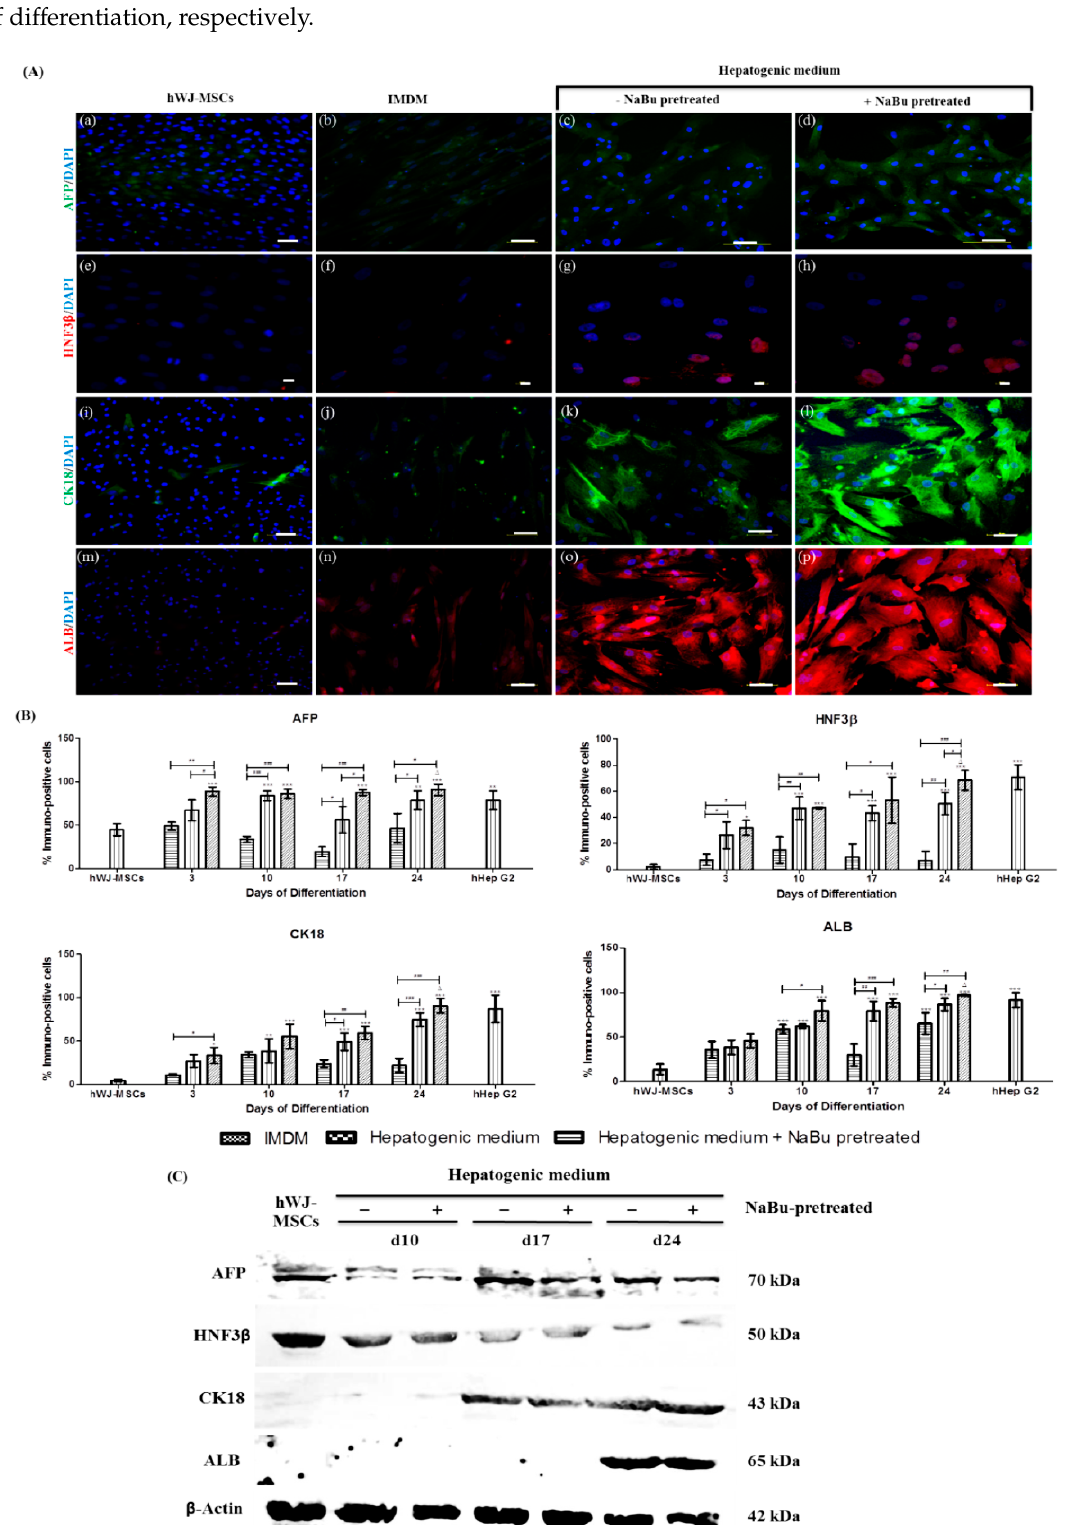
Figure 6. Immunofluorescence and a Western blot analysis of hepatic–specific protein expressions in differentiated human Wharton’s jelly–derived mesenchymal stem cells (hWJ–MSCs) with and without sodium butyrate (NaBu) pre–treatment, in combination with epidermal growth factor (EGF) and basic fibroblast growth factor (bFGF) supplementation on day 24. ( A ) hWJ–MSCs and differentiated hWJ–MSCs with and without NaBu pre–treatment and EGF and bFGF supplementation were stained with specific antibodies for AFP ( a – d ), HNF3 β ( e – h ), CK18 ( i – l ), and